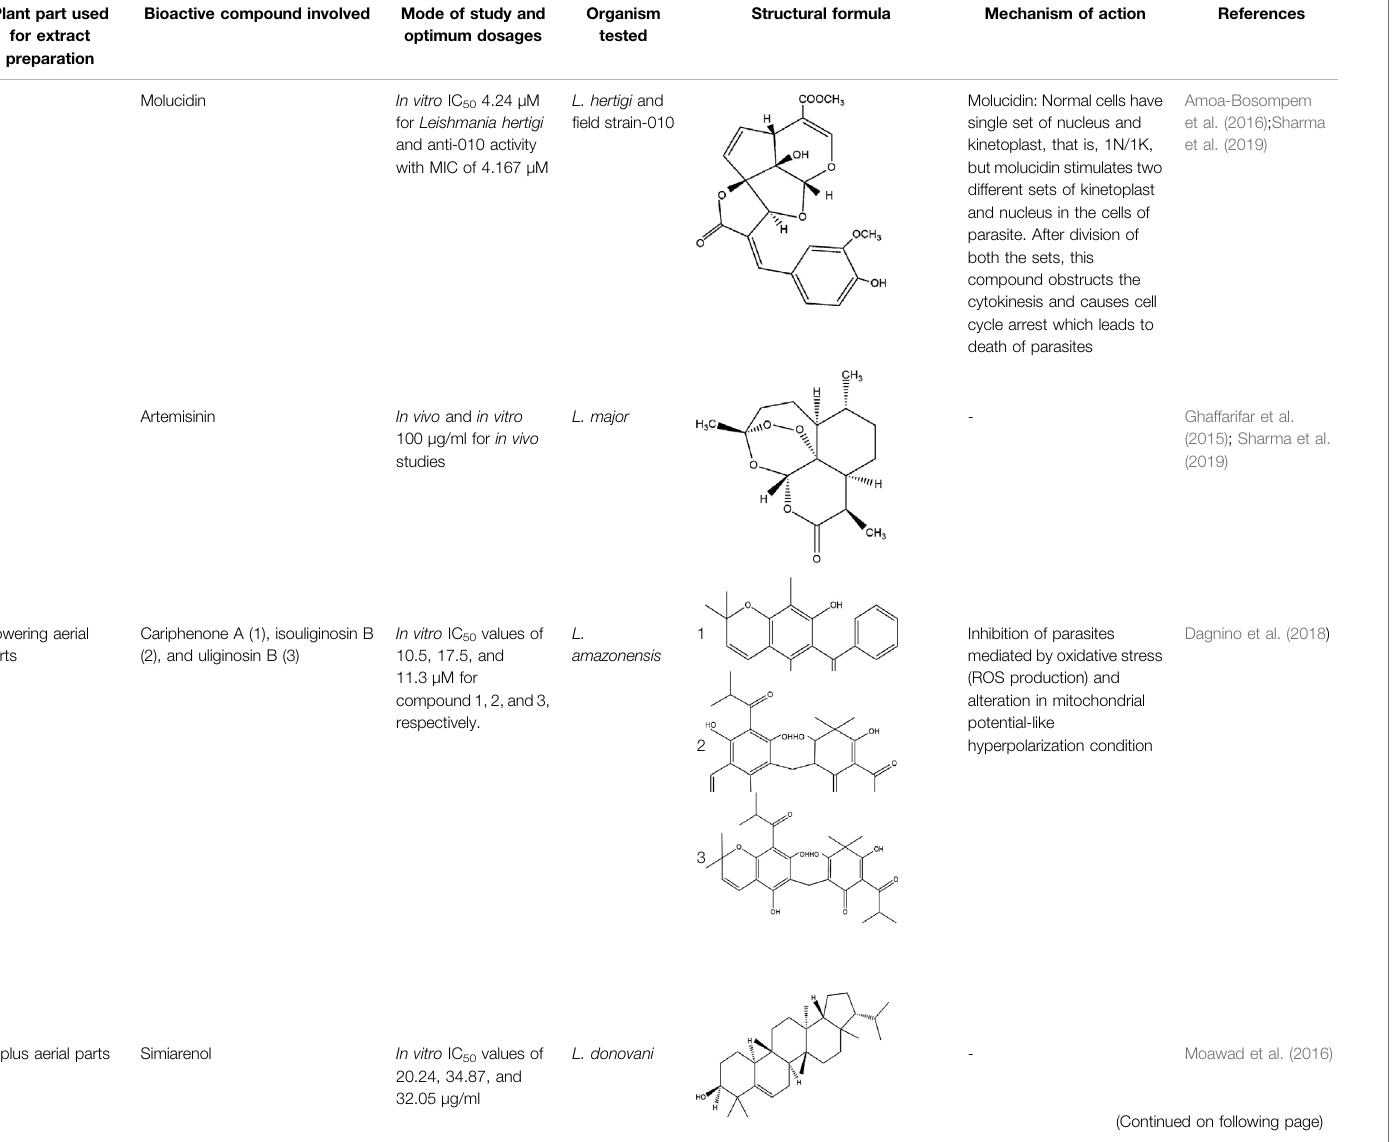
TABLE 1 | ( Continued ) Role of plant-based natural products in the treatment of